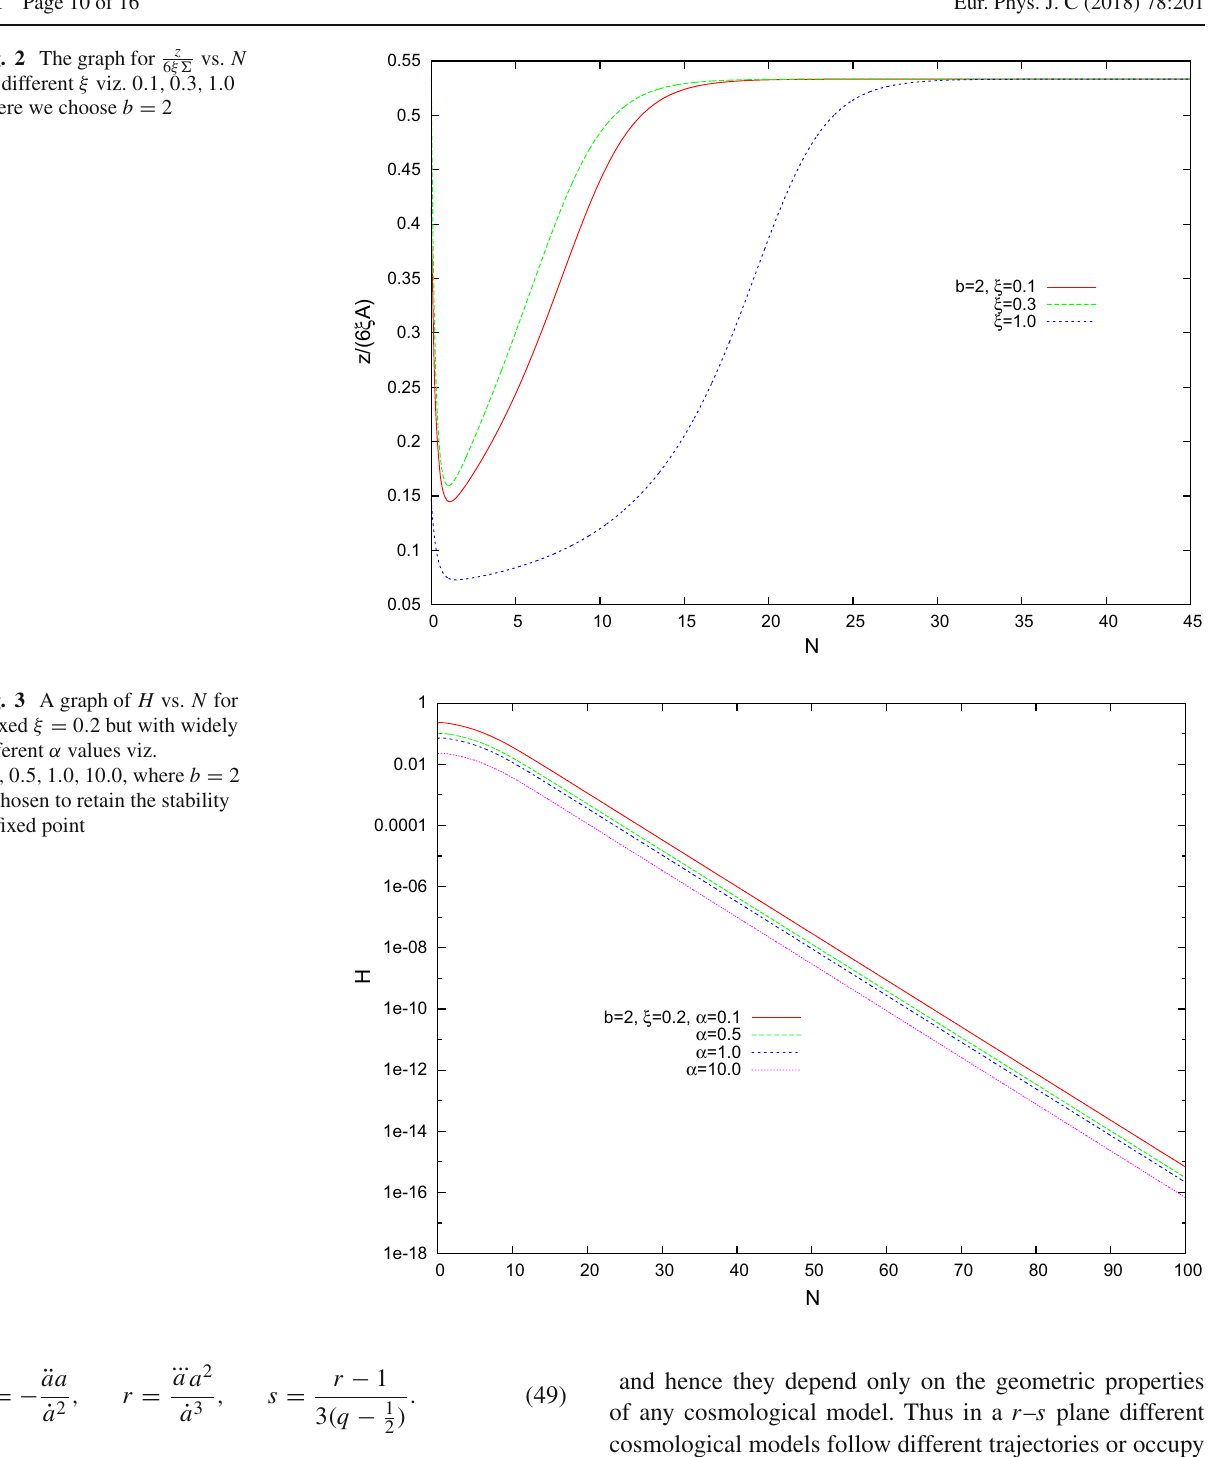
Fig. 2 The graph for z for different ξ viz. 0 . 1 , 0 . 3 , 1 . 0 where we choose b = 2